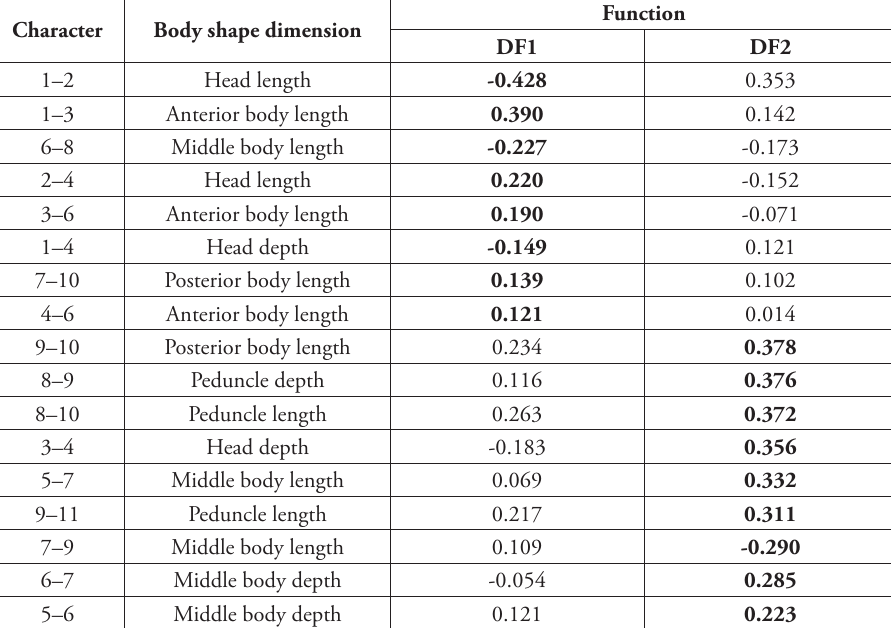
Table 3. Structure matrix coefficients that show the intra-group correlations between each of the characters and the discriminant functions. Characters of greater contribution in each discriminant function are in bold. Character